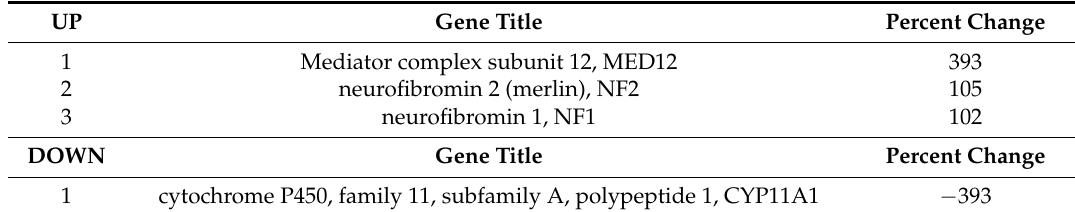
Table 20. GHK and Genes Associated with Schwann